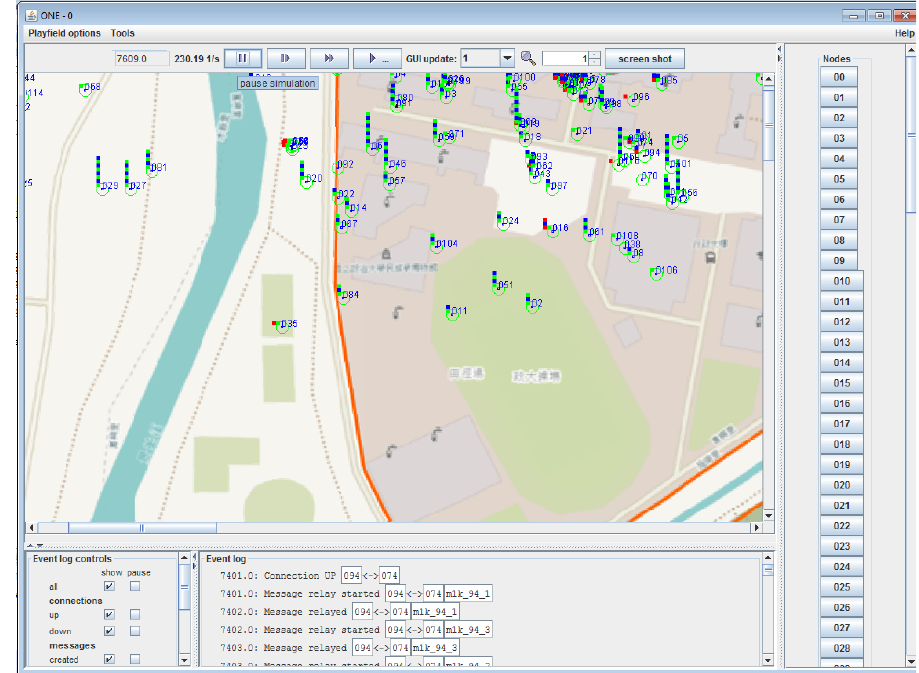
Figure 3. The ONE simulator (Helsinki University of Technology) running with the NCCU (National Chengchi University)